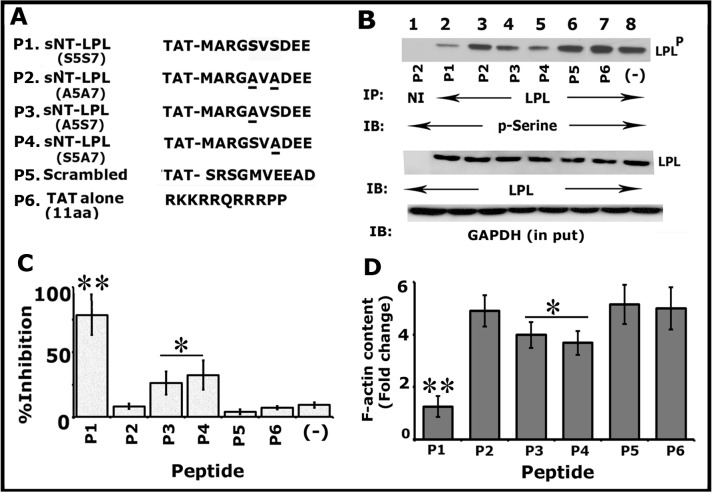
TAT-fused small molecular weight amino-terminal LPL (sNT-LPL) has the potential to reduce the phosphorylation of cellular LPL and total F-actin content.(A) Amino acid sequences of TAT-fused sNT-LPL (10aa) and control TAT alone (11aa) peptides are shown: P1) unsubstituted (S5S7); P2) double substituted (S5S7 to A5A7); P3) Ser-5 substituted with Ala (A5S7); P4) Ser-7 substituted with Ala (S5A7); P5) scrambled; P6) control TAT alone peptide. (B and C) Immunoprecipitation and immunoblotting analyses: Equal amount of osteoclast lysates were immunoprecipitated with an antibody to LPL and subjected to immunoblotting (IB) with a p-Serine antibody (top). This blot was stripped and blotted with an LPL antibody (Panel B; middle). An equal amount of total protein (Input) used for immunoprecipitation was assessed by direct immunoblotting of lysates with a GAPDH antibody. These results represent one of the three experiments performed with the similar results. Percent inhibition of phosphorylation of cellular LPL with indicated peptides is provided as a graph. **p<0.01; *p<0.05 versus double substituted (A5A7), scrambled, or TAT alone -peptide transduced cells. The data shown are the mean ± SD of three different immunoblots. (D) The effect of sNT-LPL peptides on F-actin content: The F-actin content was determined in osteoclasts transduced with indicated peptides by rhodamine-phalloidin binding. Fold change in F-actin levels are provided. The F-actin content of the 0-min cells was assigned a value of 1.0, and all other values were expressed relative to the 0-mins values. Values plotted are mean±SD from three experiments **p<0.01; *p<0.05 versus P2, P5, or P6 peptide transduced cells.